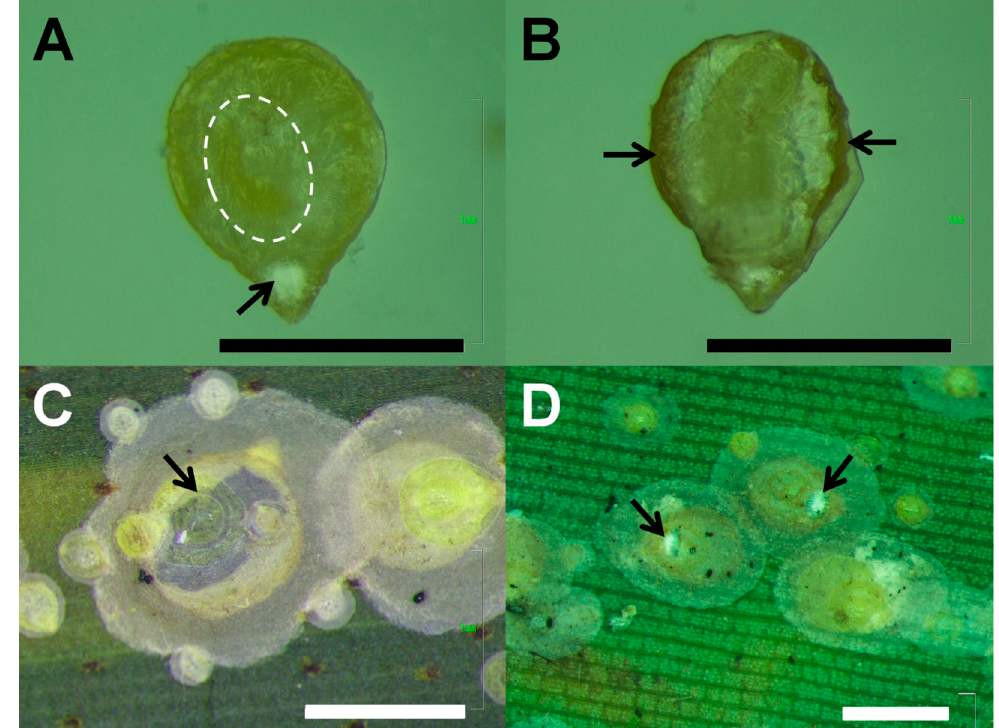
Figure 2. Indicators of parasitization by Comperiella calauanica on Aspidiotus rigidus : ( A ) white, powdery residue (pointed to by arrow) occurring on ventral pygidium of an isolated scale parasitized by a C. calauanica third instar larva (location in the scale indicated by broken oval); ( B ) meconial deposits (pointed to by arrows) produced by the C. calauanica fourth instar larva visible in the middle of the isolated, mummified scale; ( C ) dark-colored, C. calauanica late pupa inside an intact, mummified scale (pointed to by arrow); and ( D ) exit holes (pointed to by arrows) produced by adult C. calauanica upon emergence from their mummified hosts. Scale bars represent 1 mm.